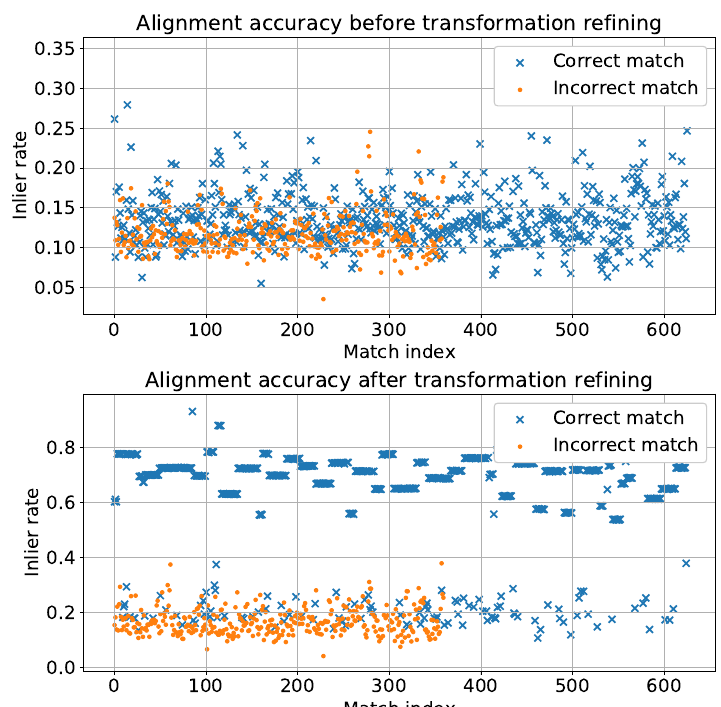
Figure 5. Alignment accuracy before and after transformation refining. Before the transformation refining, neither the transformation estimated from a correct match, nor that from an incorrect match can align the query road point set to the reference road point set accurately. After the transformation refining, the alignment accuracy under most of the transformations estimated from the correct matches improves greatly, while that of the incorrect match does